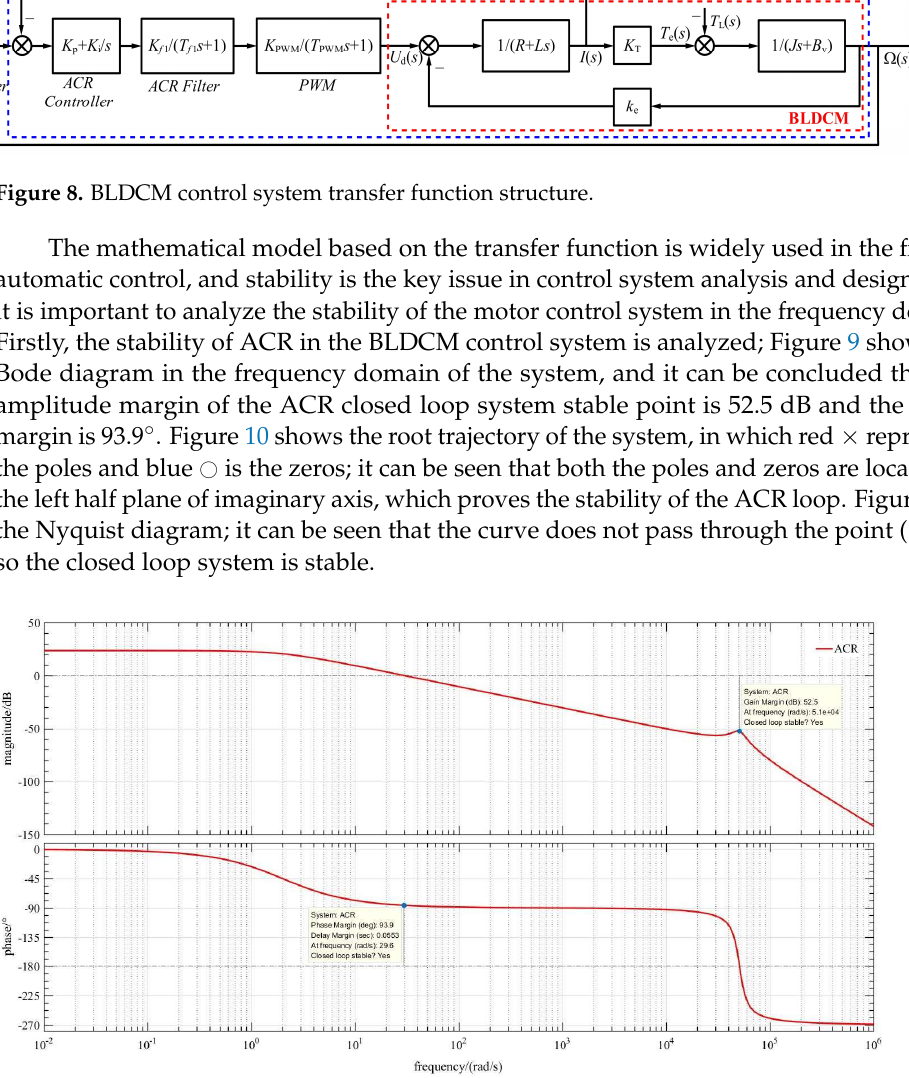
Figure 10. Root trajectory of ACR control system.